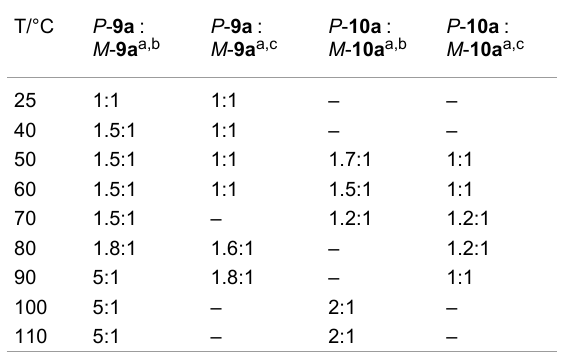
Table 2: Monitoring diastereoselectivity in the formation and/or inter- conversion of the diastereoisomers of imidazolidines 9a and oxazolidines 10a